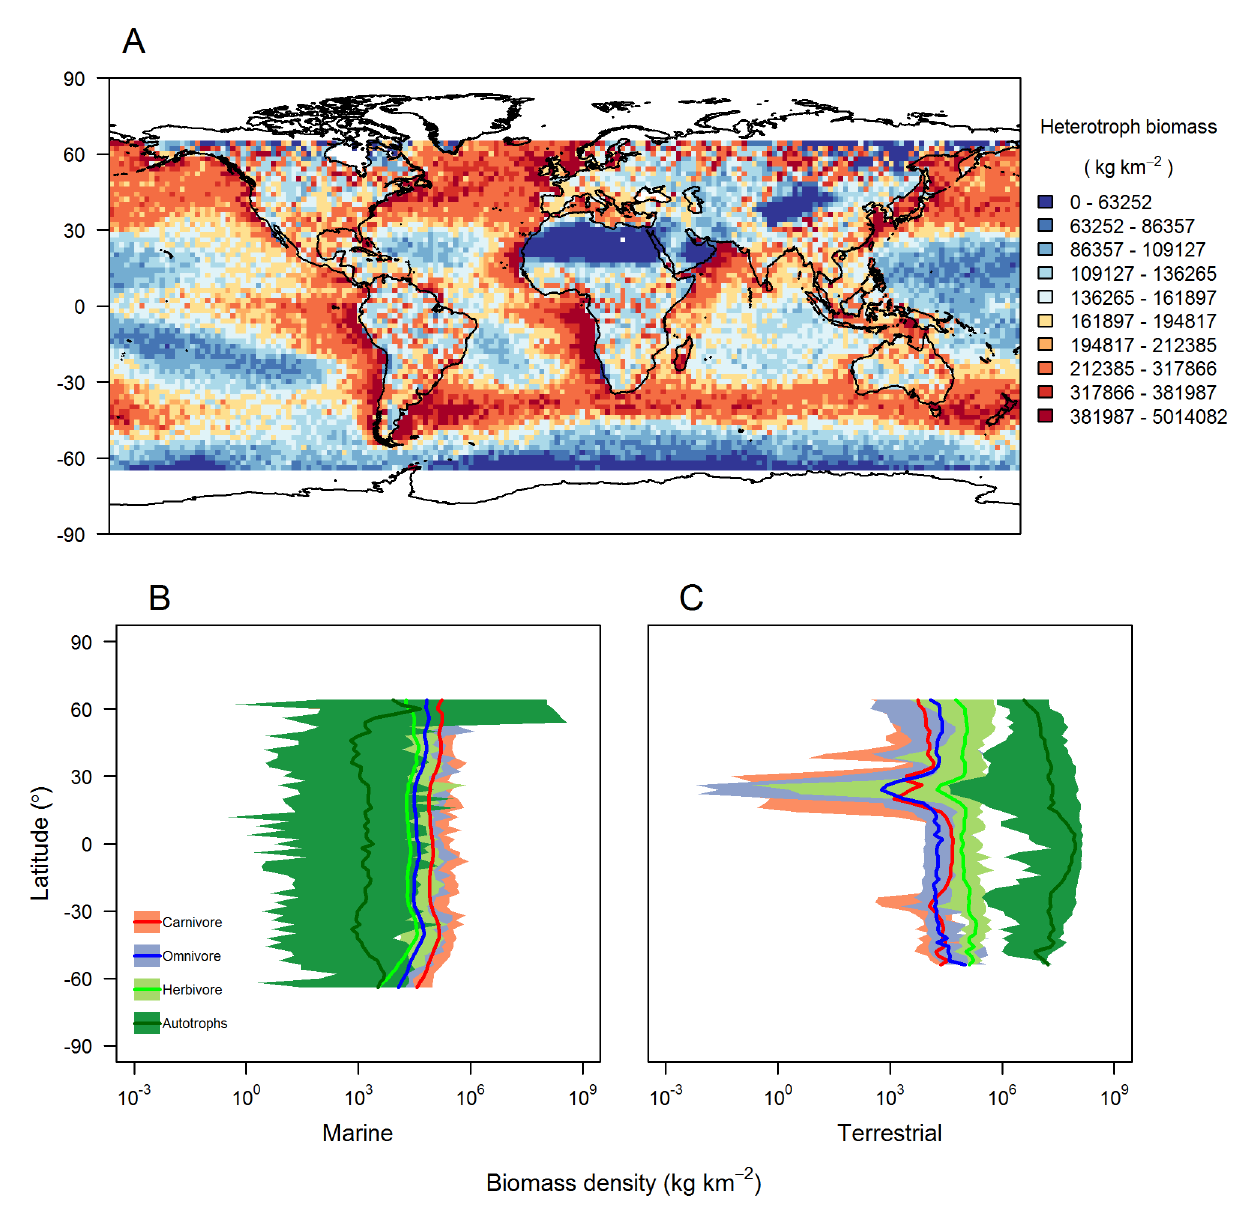
Figure 7. Emergent global-level ecosystem properties. Properties emergent from the model after a 100-y global (65 u N to 65 u S) simulation using a grid-cell resolution of two degrees. (A) The spatial distribution of annual mean heterotroph biomass density; breaks in the colour scheme were based on quantiles in the data. (B, C) Latitudinal gradients in biomass density; solid lines represent means for each trophic level, and shading represents the range of values across all longitudes in each latitude